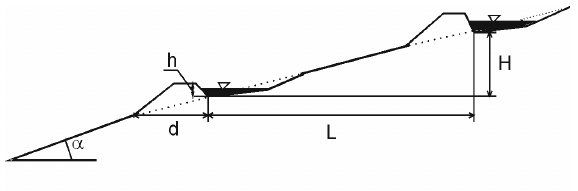
Fig. 2. Ridged terraces without water outflow (where: L, H – horizontal and vertical spacing, respectively)